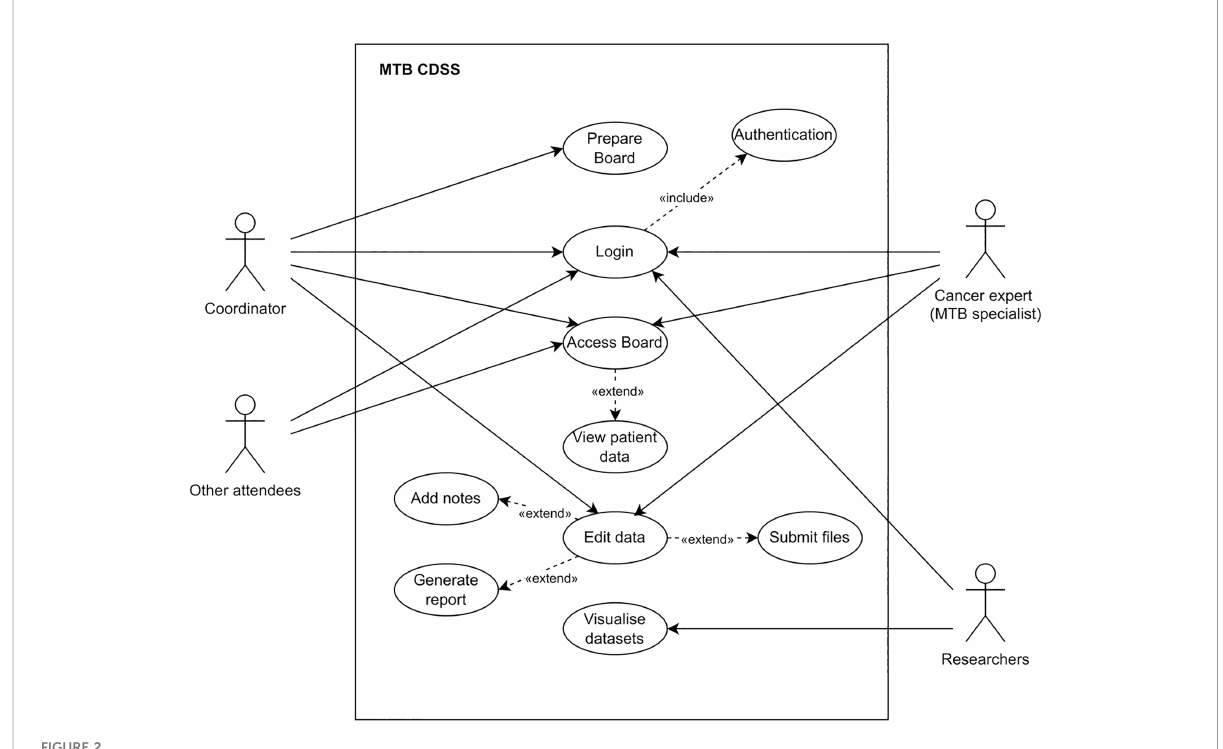
FIGURE 2 UML Use Case Diagram for the